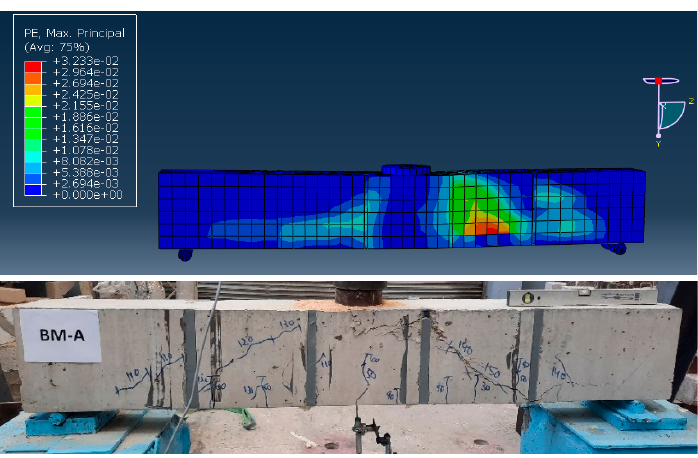
Figure 15. Maximum principal plastic strain for BM ‐